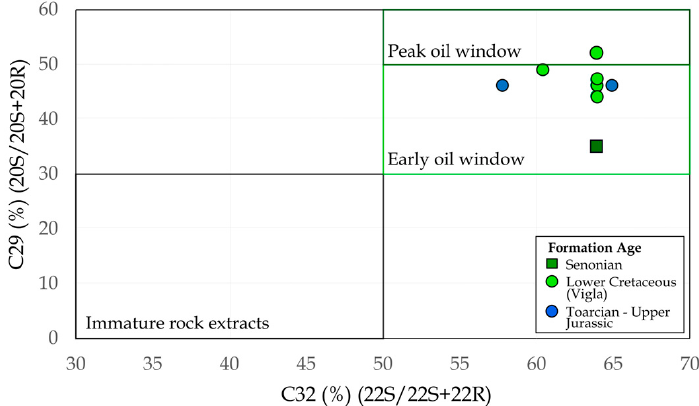
Figure 6. Thermal maturity evaluation plot based on biomarker maturity parameters C29 (%) 20S/(20S + 20R) sterane versus C32 (%) 22S/(22S + 22R) hopane as modified after [77].